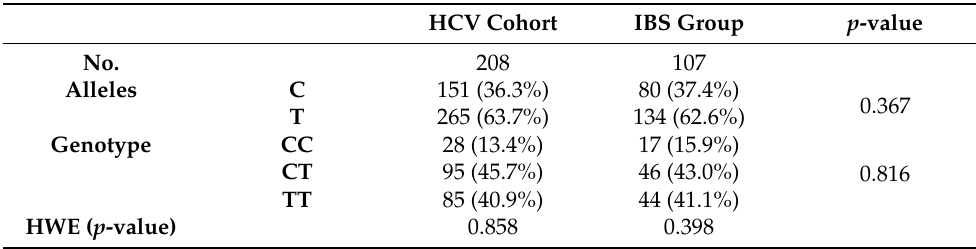
Table 2. Summary of characteristics of TRPM5 rs886277 polymorphism in patients infected with HCV compared to the Iberian population (data from 1000 Genomes Project Phase 3)